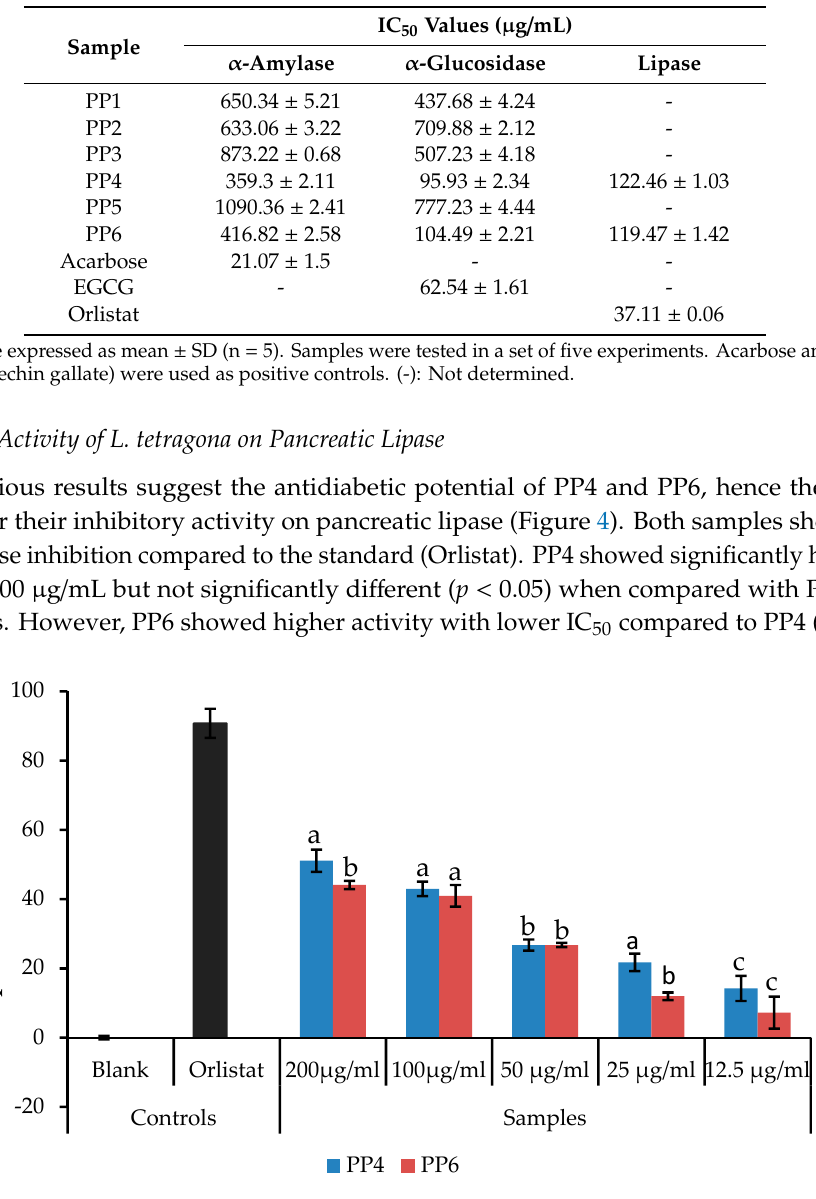
Figure 4. The inhibition of pancreatic lipase by the active fractions from the methanolic extract of L. tetragona . The values are expressed as mean ± SD (n = 5). Bars with different letters at each concentration are significantly different ( p < 0.05).